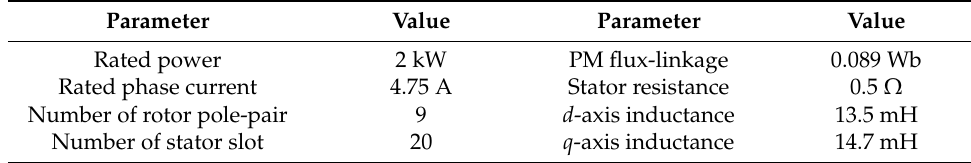
Table 1. Parameters of the FPFTPM